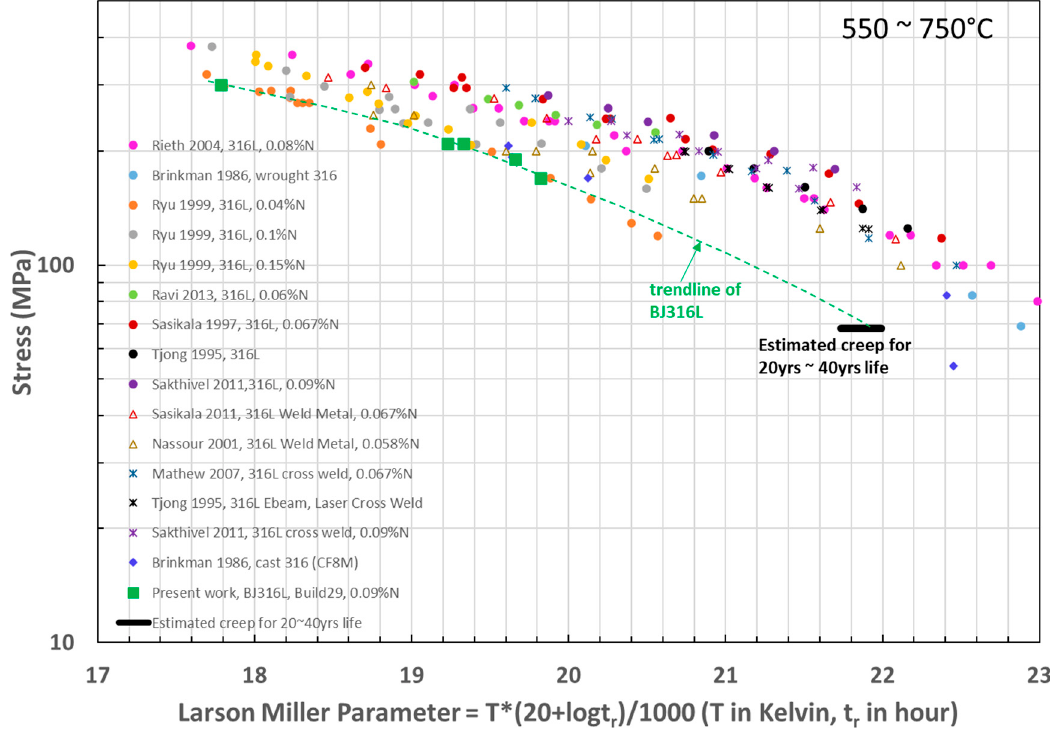
Figure 8. Larson Miller plot showing the compiled cast, wrought and welded 316L creep data in the literature [17–27], together with Binder Jet 316L baseline data in the present work.